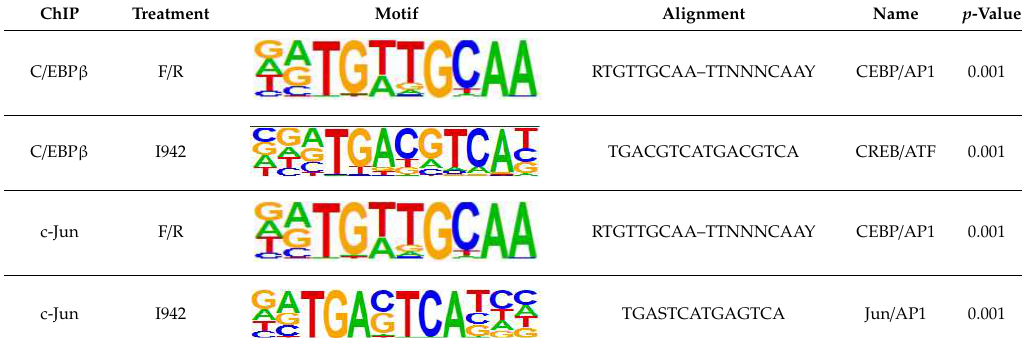
Table 1. Results of c-Jun and C/EBPβ ChIP-SEQ. Human umbilical vein endothelial cells (HUVECs) were incubated for 48 h in the presence or absence of I942 or forskolin and rolipram (F/R). Following